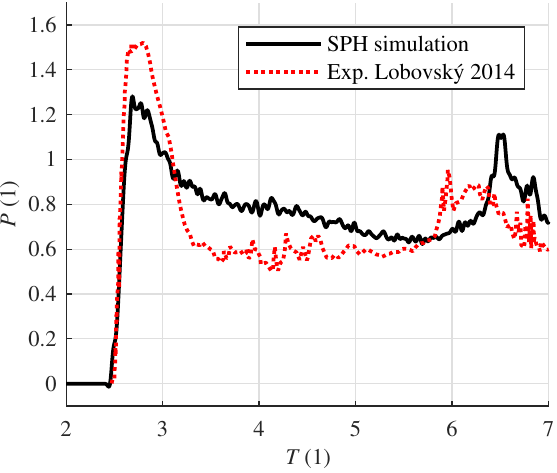
Fig. 10. Non-dimensional pressure as a function of non- dimensional time at sensor P1. Exp. Lobovský 2014 [2].